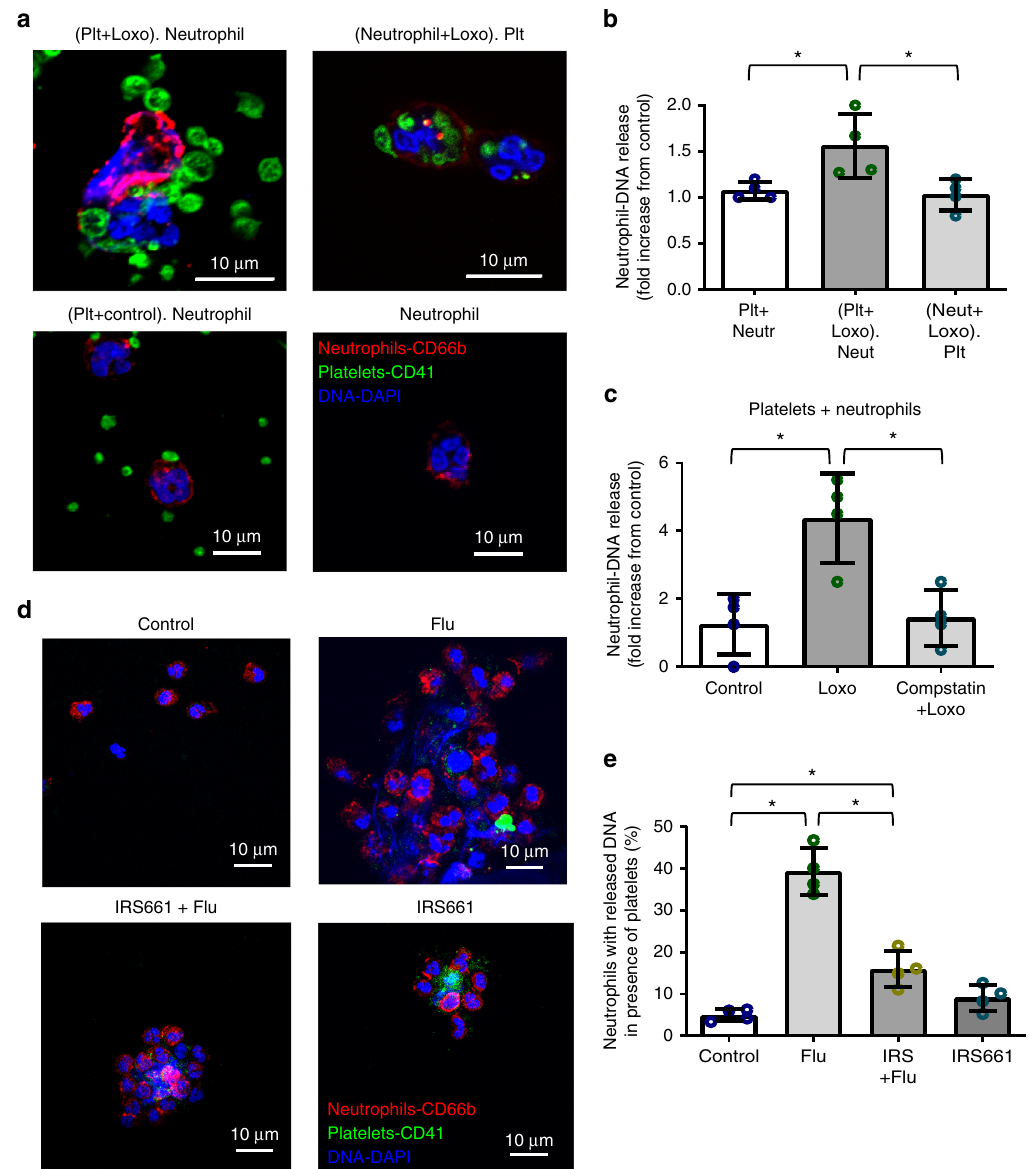
Fig. 7 Platelet-TLR7 solely mediates neutrophil-DNA release through C3. Platelets and neutrophils were isolated from human blood. Each population was pretreated for 15 min with a TLR7 agonist (1 mM Loxoribine, Loxo) and then incubated with the other population for 30 min. All experiments were carried out at an approximately physiological ratio of 50 platelets:1 neutrophil. a Confocal microscopy of the incubated cells. Cells were stained with (CD41-FITC- platelets; CD66b-APC-neutrophils; DAPI-DNA) and visualized with a confocal microscope. b Quantitation of the confocal images in ( a ), p = 0.017, F = 6.624; df = 2. c DNA release from neutrophils in the presence of platelets pretreated with a C3 inhibitor, compstatin (0.088 mg/mL) for 10 min and then stimulated with Loxo for 30 min ( p = 0.0033, F = 11.51, df = 2). d Assessment of neutrophil-DNA release by confocal images of isolated platelets and neutrophils treated with in fl uenza WSN/33 in the presence or absence of the TLR7 inhibitor IRS661. e Quantitation of the confocal images in ( d ), p < 0.0001; F = 61.07, df = 3. In all cases data in the graphs are represented as the average ± SD. Statistical signi fi cance was measured by ANOVA followed